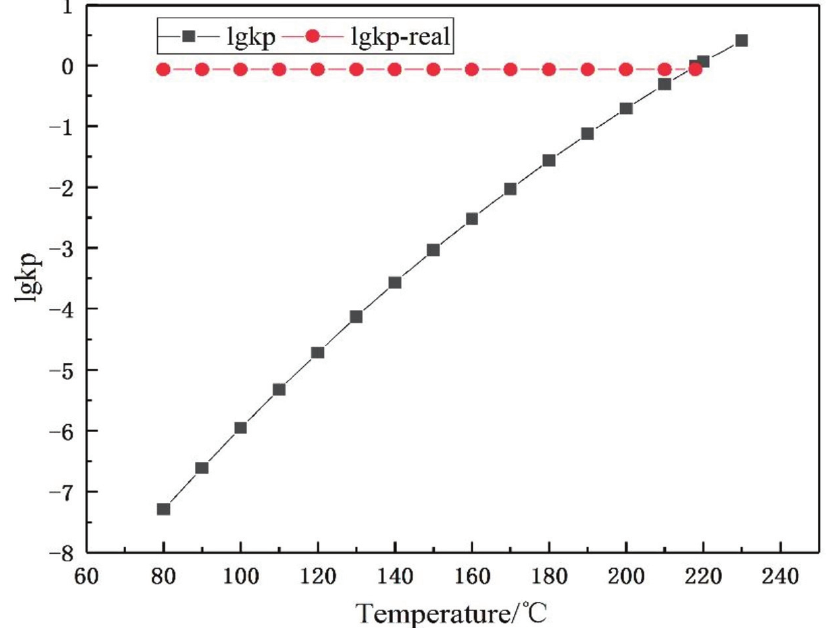
Figure 4. Determination of crystallization temperature of NH 4